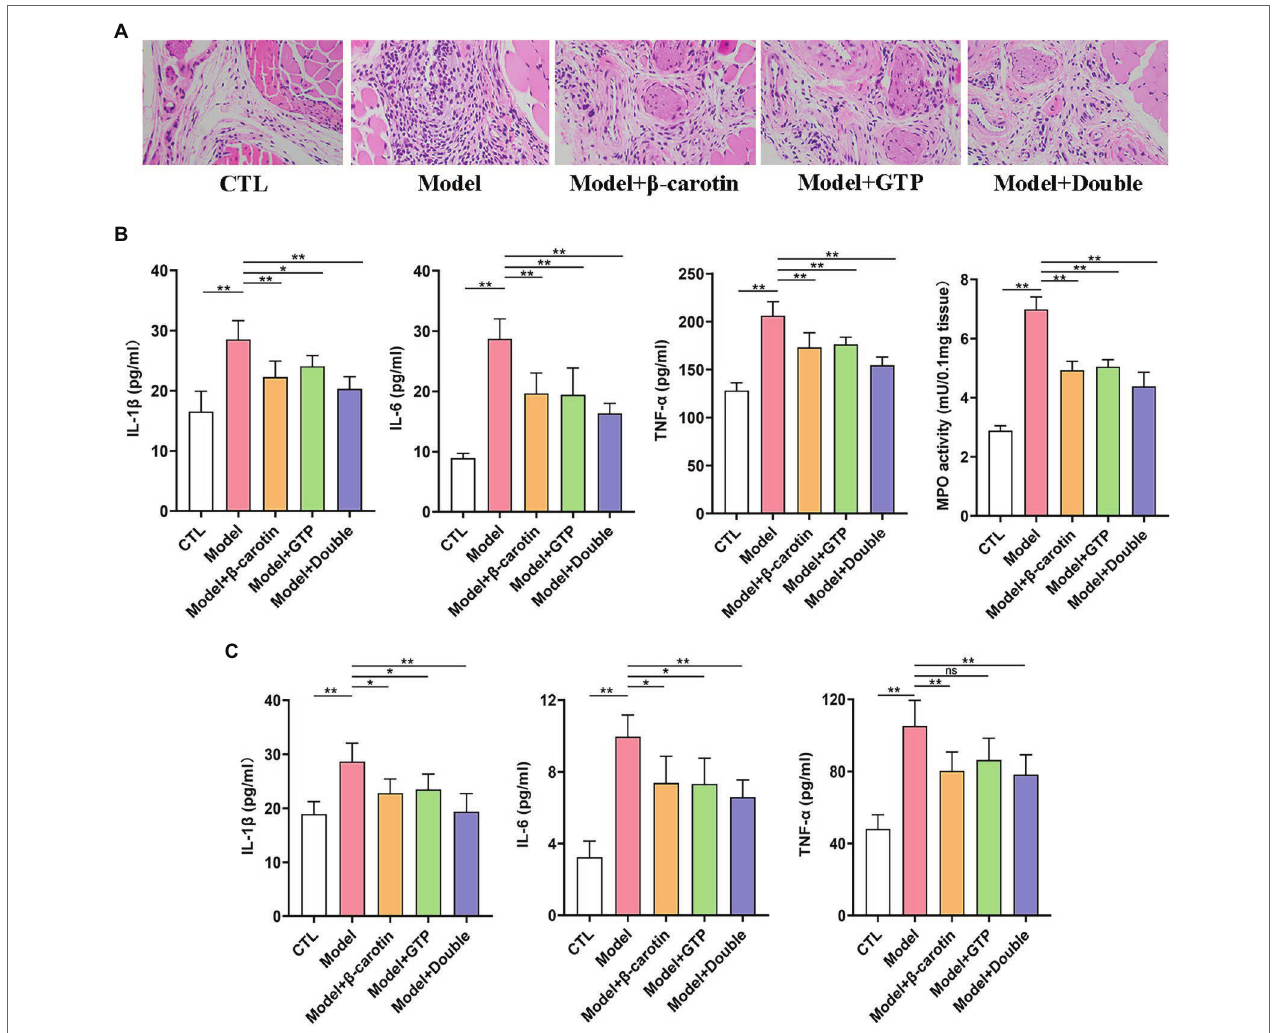
FIGURE 2 | Effects of β -carotin and green tea powder on the improvement of gout-related inflammation markers in mice. (A) HE analysis of the footpad. (B) Level of cytokines [i.e., interleukin-1 β (IL-1 β ), interleukin-6 (IL-6), and tumor necrosis factor- α (TNF- α )] and myeloperoxidase (MPO) activity in the foot joint tissues of five groups of mice based on ELISA. (C) Level of cytokines (i.e., IL-1 β , IL-6, and TNF- α ) in the serum of five groups of mice based on ELISA. * p < 0.05, ** p < 0.01, and “ns” represents no statistical